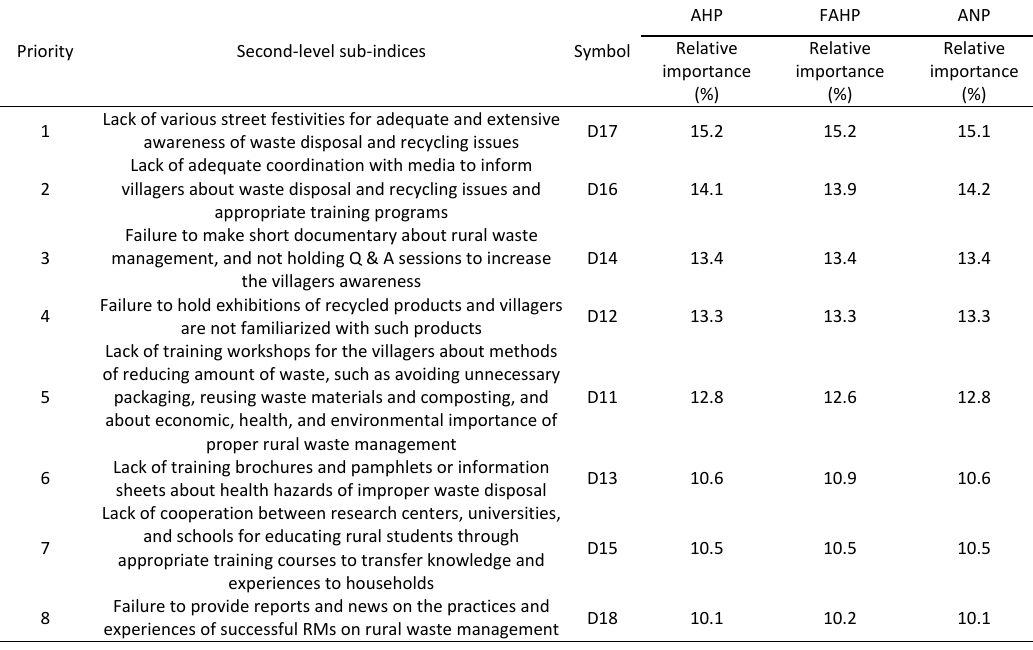
Table 6: Prioritization of weaknesses and relative importance values of the sub-indices of the D1 index based on AHP, FAHP, and ANP